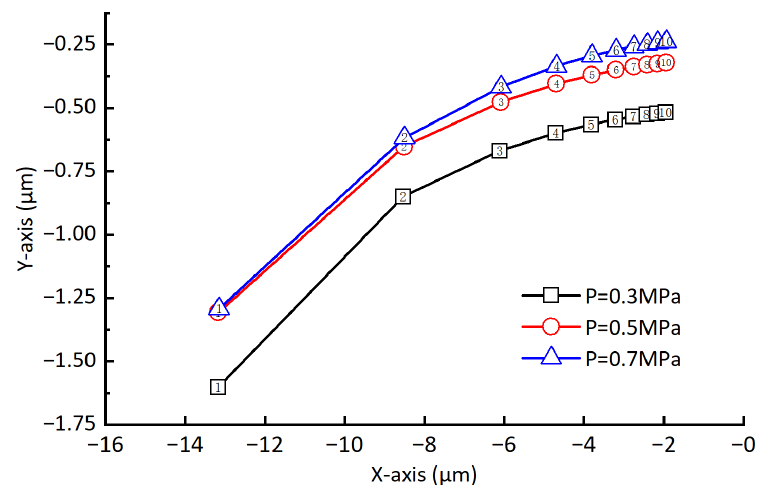
Figure 8. Static equilibrium position under different pressures and rotating speeds.